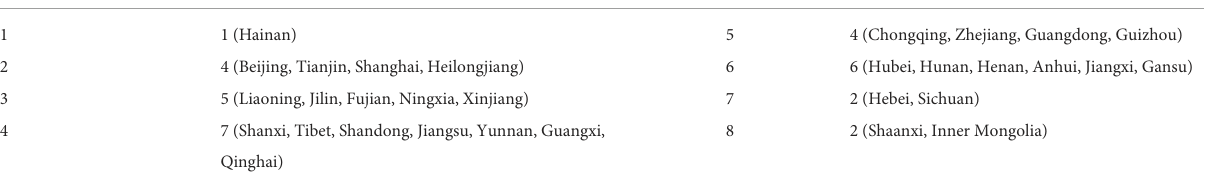
TABLE 1 The final result of spatial binary weight matrix using Rook criterion. Number of neighbors Frequency (names) Number of neighbors Frequency